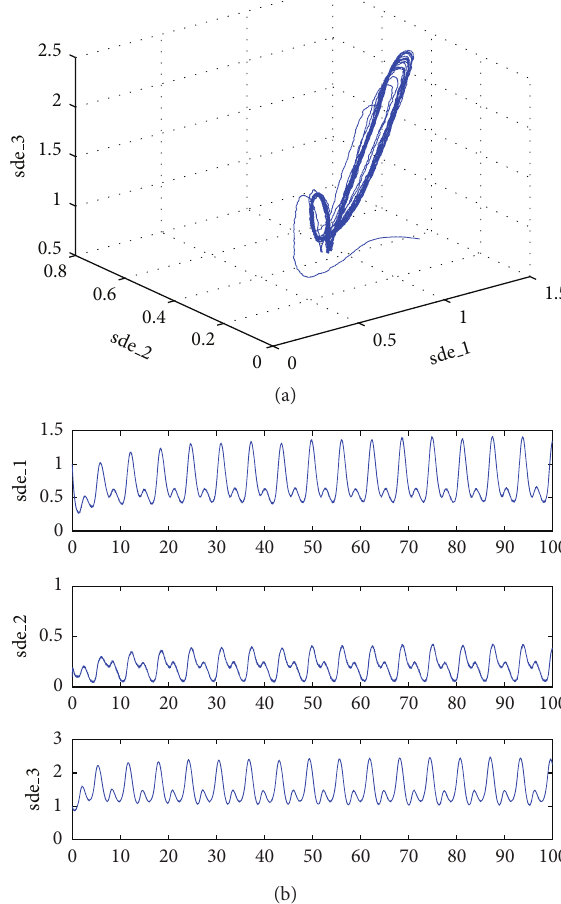
Figure 15: Stochastic system with a white noise 𝑢 𝑖𝑖 = 0.1 , 𝑖 = 1, 2, 3 .